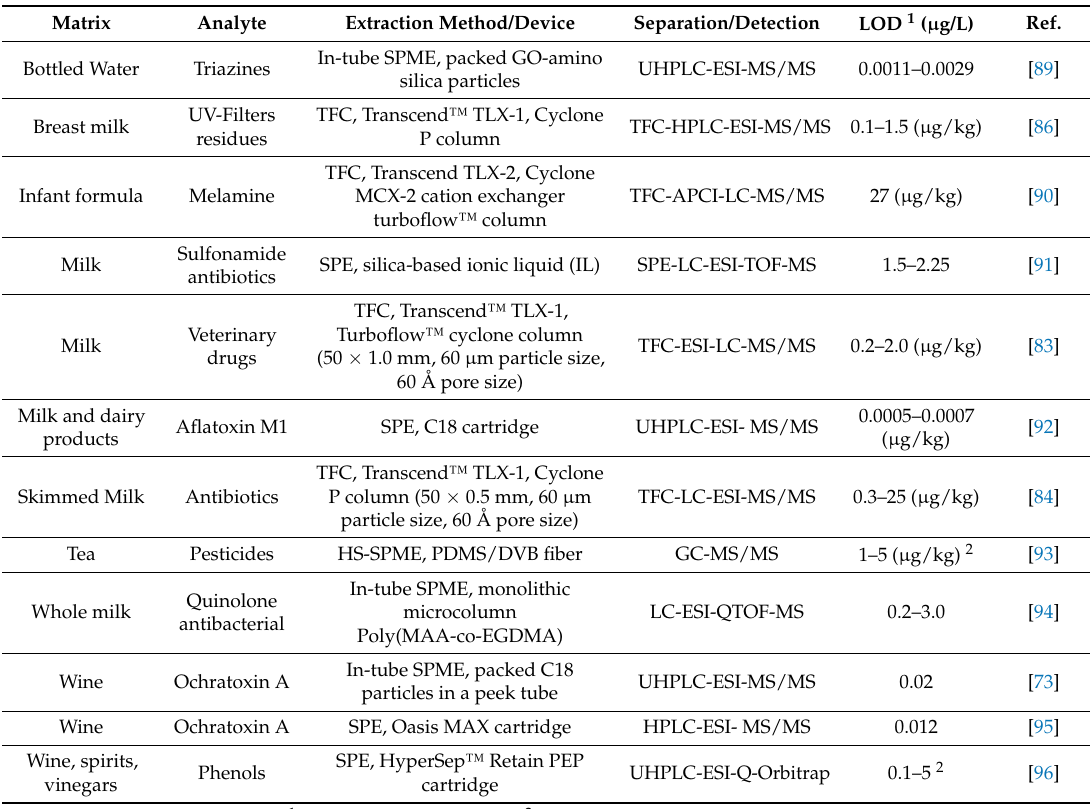
Table 4. Representative applications of on-line extraction—chromatography—tandem mass spectrometry to the analysis of